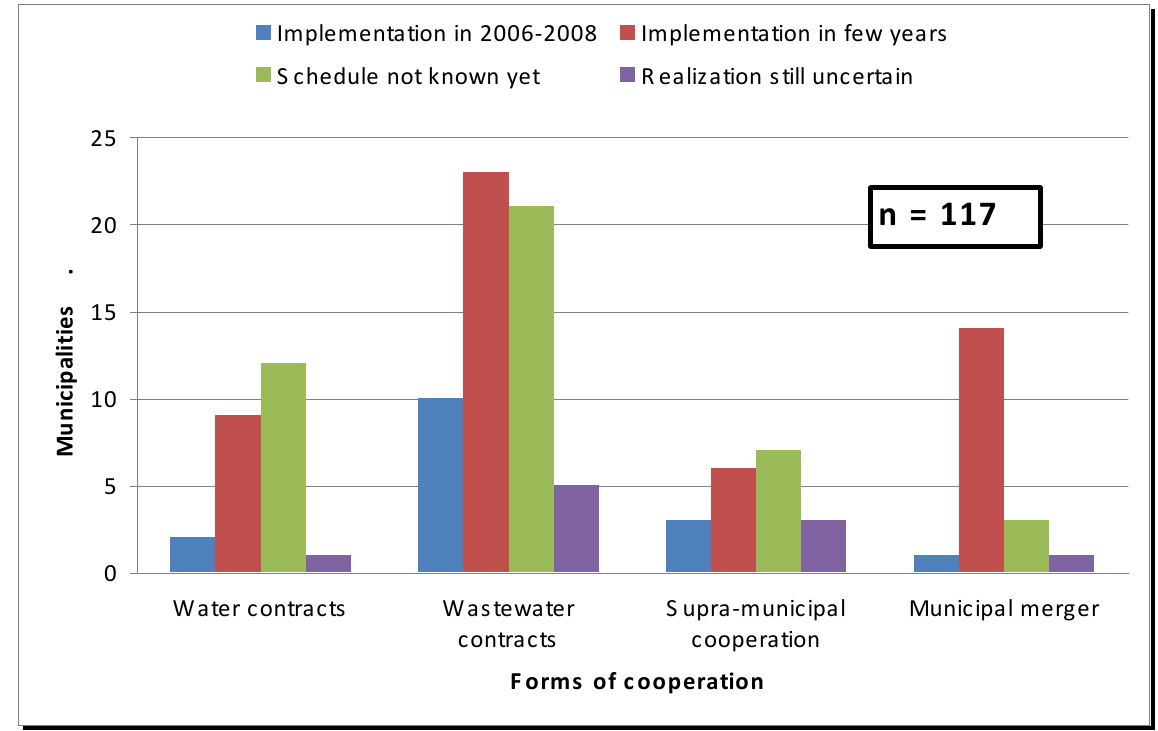
Figure 3. Implemented and planned bilateral contracts between water and wastewater utilities in 2008